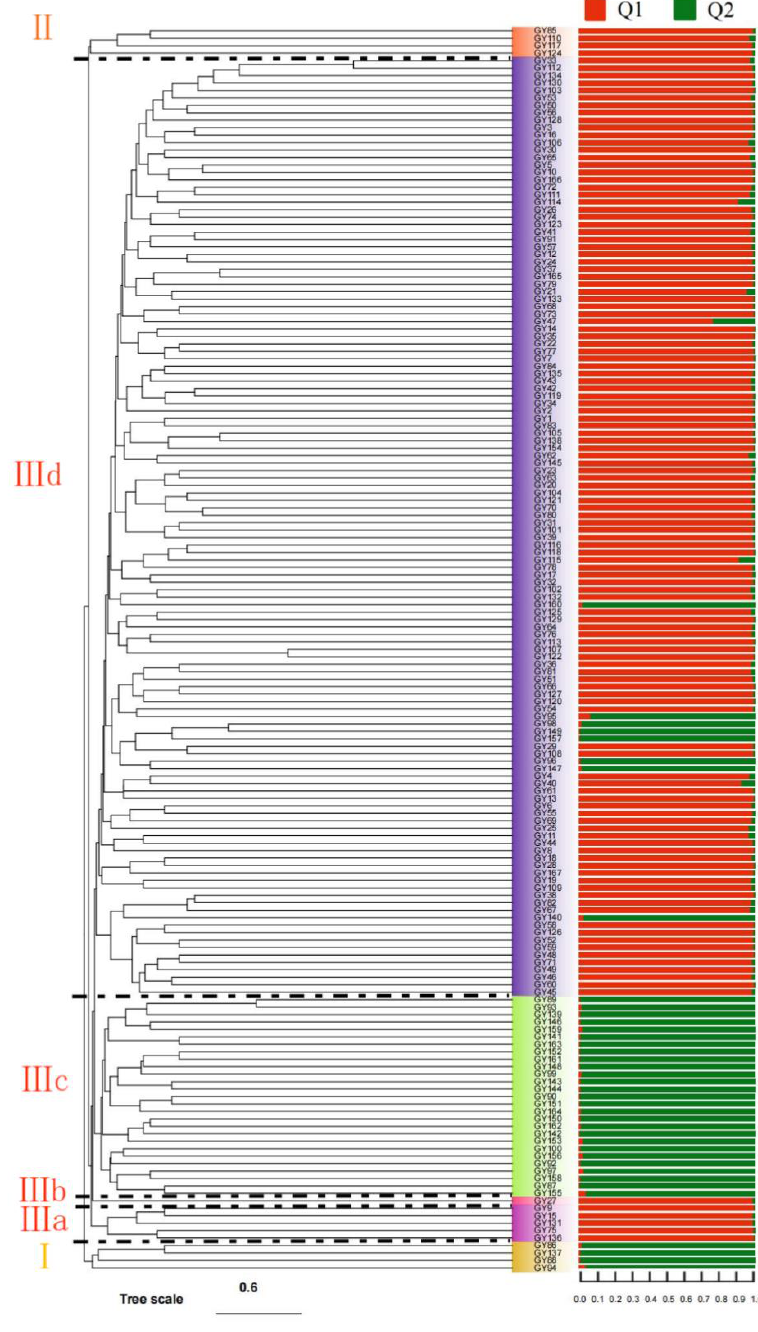
Figure 3. Phylogenetic tree and genetic structure of 167 C. oleifera germplasm resources based on SSR Markers. Note: The stacked bar charts represent the Q value of different assigned groups. Q1 and Q2 represent two groups when the genetic structure of 167 C. oleifera germplasm resources is divided into two groups.